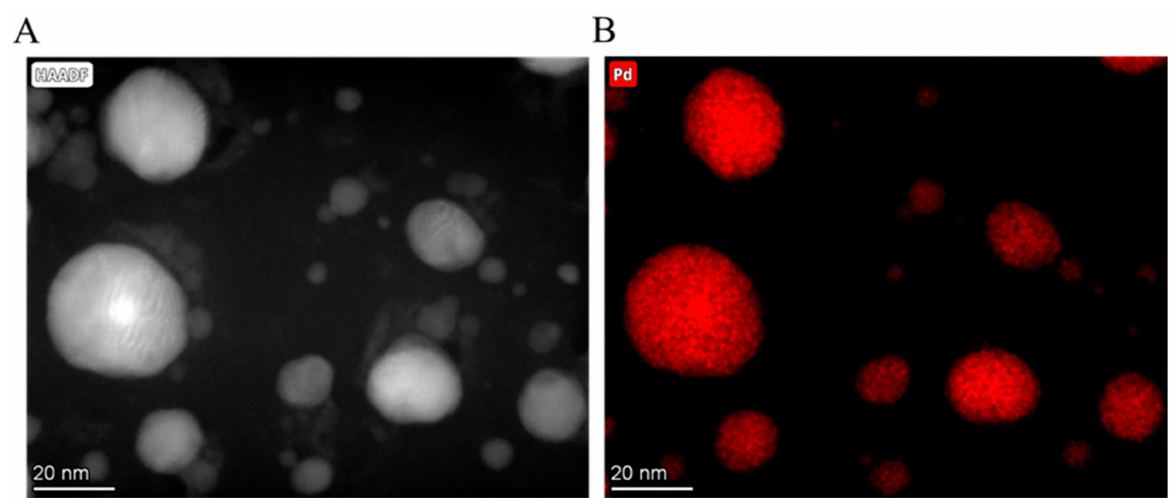
Figure 4. High-angle annular dark field (HAADF) image ( A ) and elemental mapping of the palladium nanoparticles on the surface of the carbon foil ( B ).